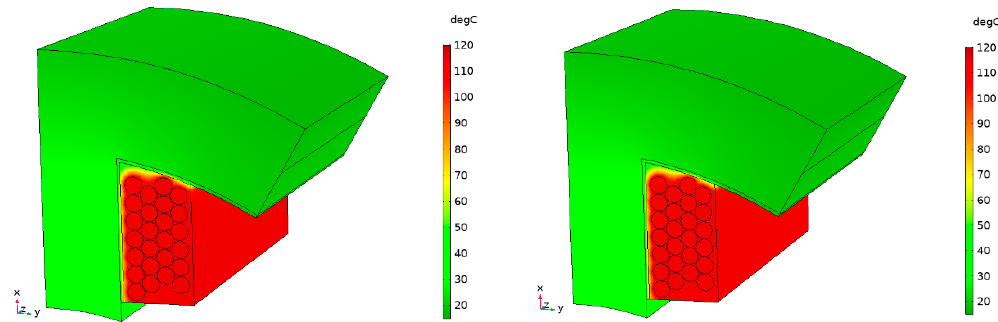
Figure 6. Temperature distribution for WJ1 ( left ) and WJ2 ( right ).